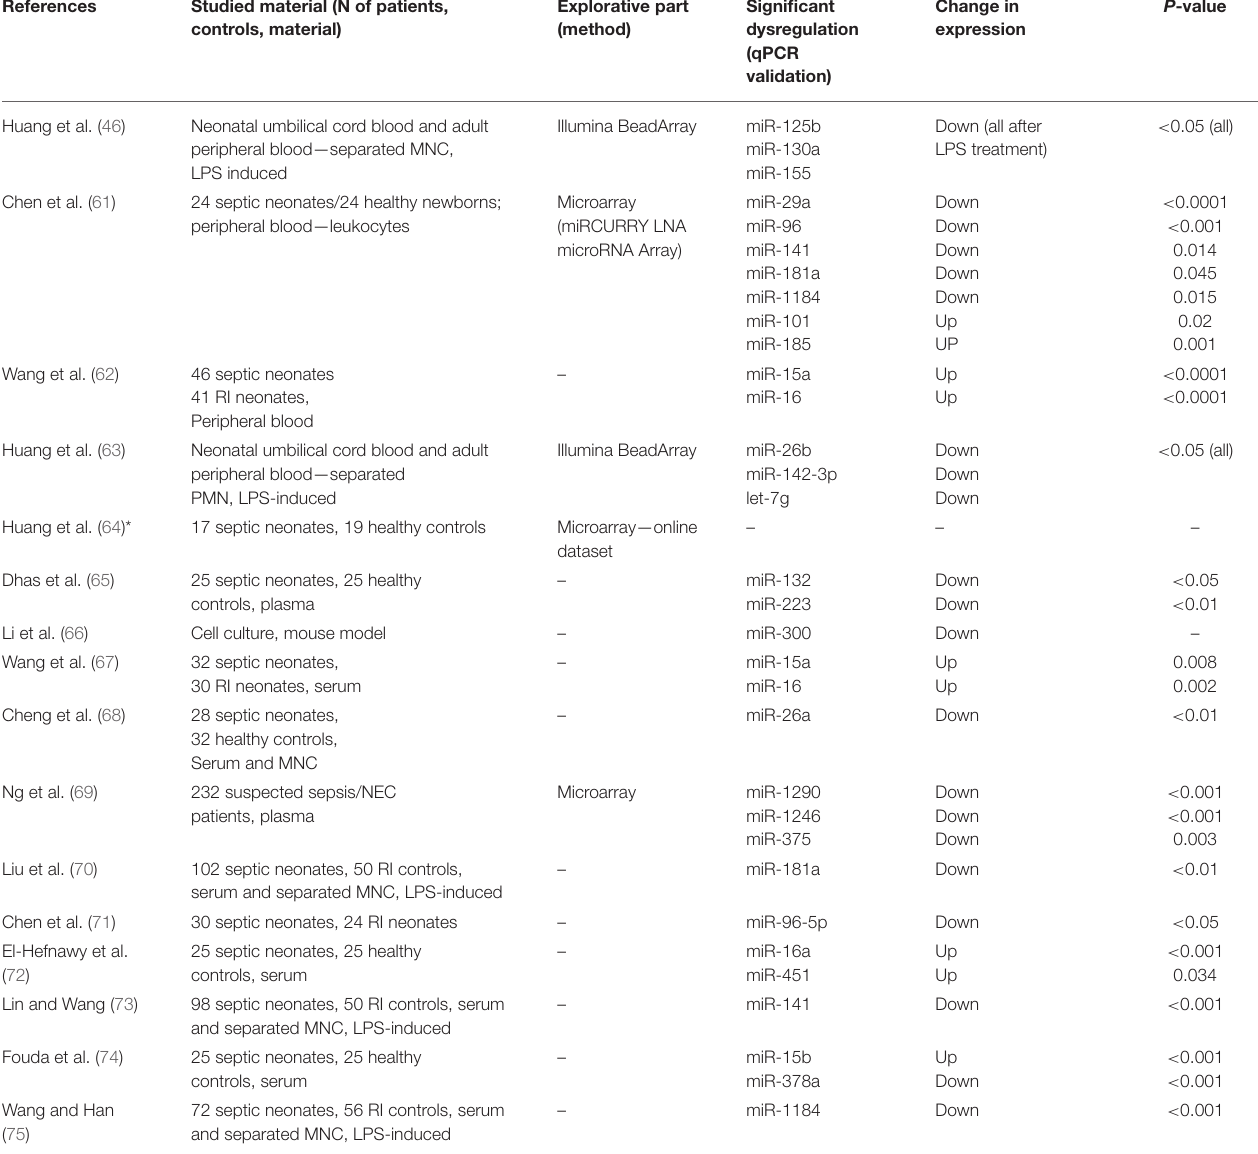
TABLE 1 | Summary of original research articles on miRNA dysregulation in patients with neonatal